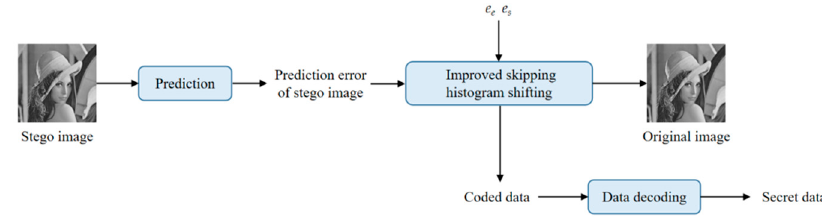
Figure 6. The data extraction and image recovery process.